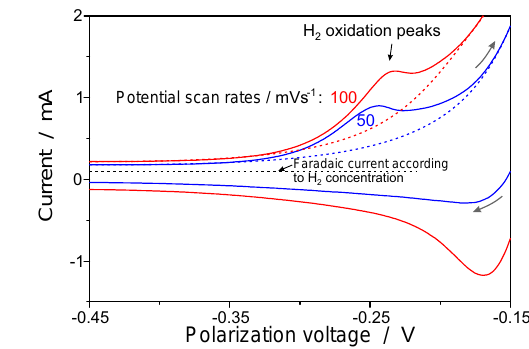
Figure 6. Voltammograms at higher potential scan rates than shown in Fig. 5.